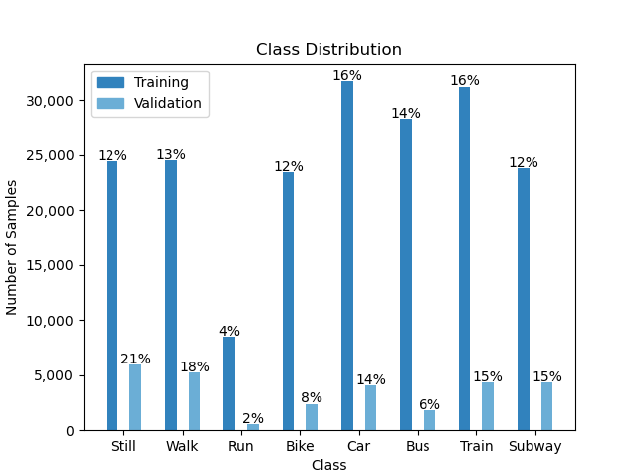
Figure 1. The histogram of the distribution of the labels in the training and validation set.